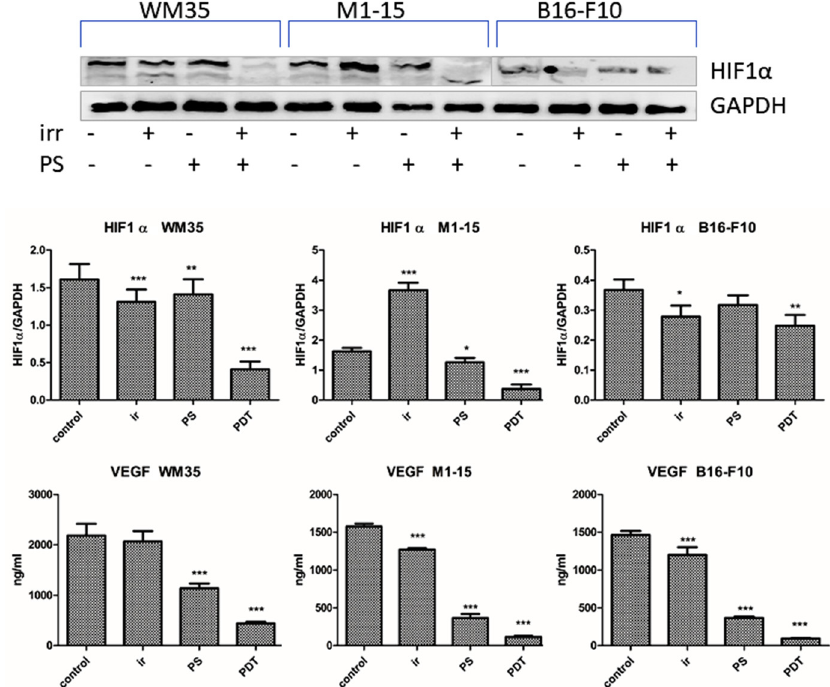
Figure 7. Angiogenesis markers. HIF1 α WB images: 1 = control, 2= irradiated control, 3= THPP, 4= PDT (upper panel). Graphical representation of quantitative WB results; VEGF (ng/mg protein). Each bar represents mean ± SD ( n = 3) * = p < 5.0 × 10 − 2 , ** = p < 1.0 × 10 − 2 , *** = p < 1.0 × 10 − 3 to control. 1 = control, 2 = irradiated (100 mJ/cm 2 ), 3 = THPP (15 µg/mL), 4 = PDT (THPP 15 µg/mL and irradiation 100 mJ/cm 2 ).